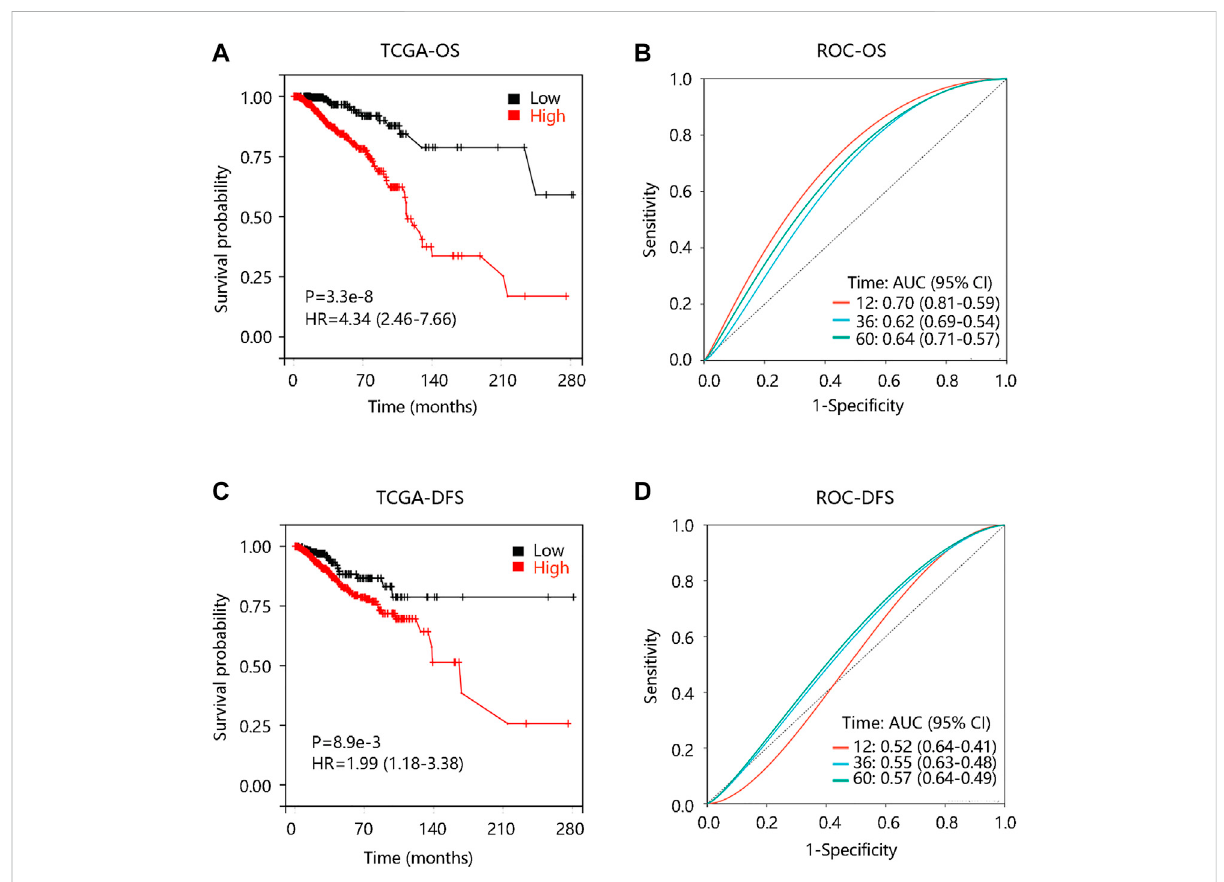
FIGURE 5 Prognostic analysis of FN1 expression in breast cancer (BRCA) based on TCGA data from the cBioportal database. (A) High FN1 expression predicted poor overall survival (OS)in BRCA. (B) Receiver operating characteristic(ROC) curveofFN1 expression in predicting OS status inBRCA. (C) High FN1 expression predicted poor disease-free survival (DFS) in BRCA. (D) ROC curve of FN1 expression in predicting DFS status in